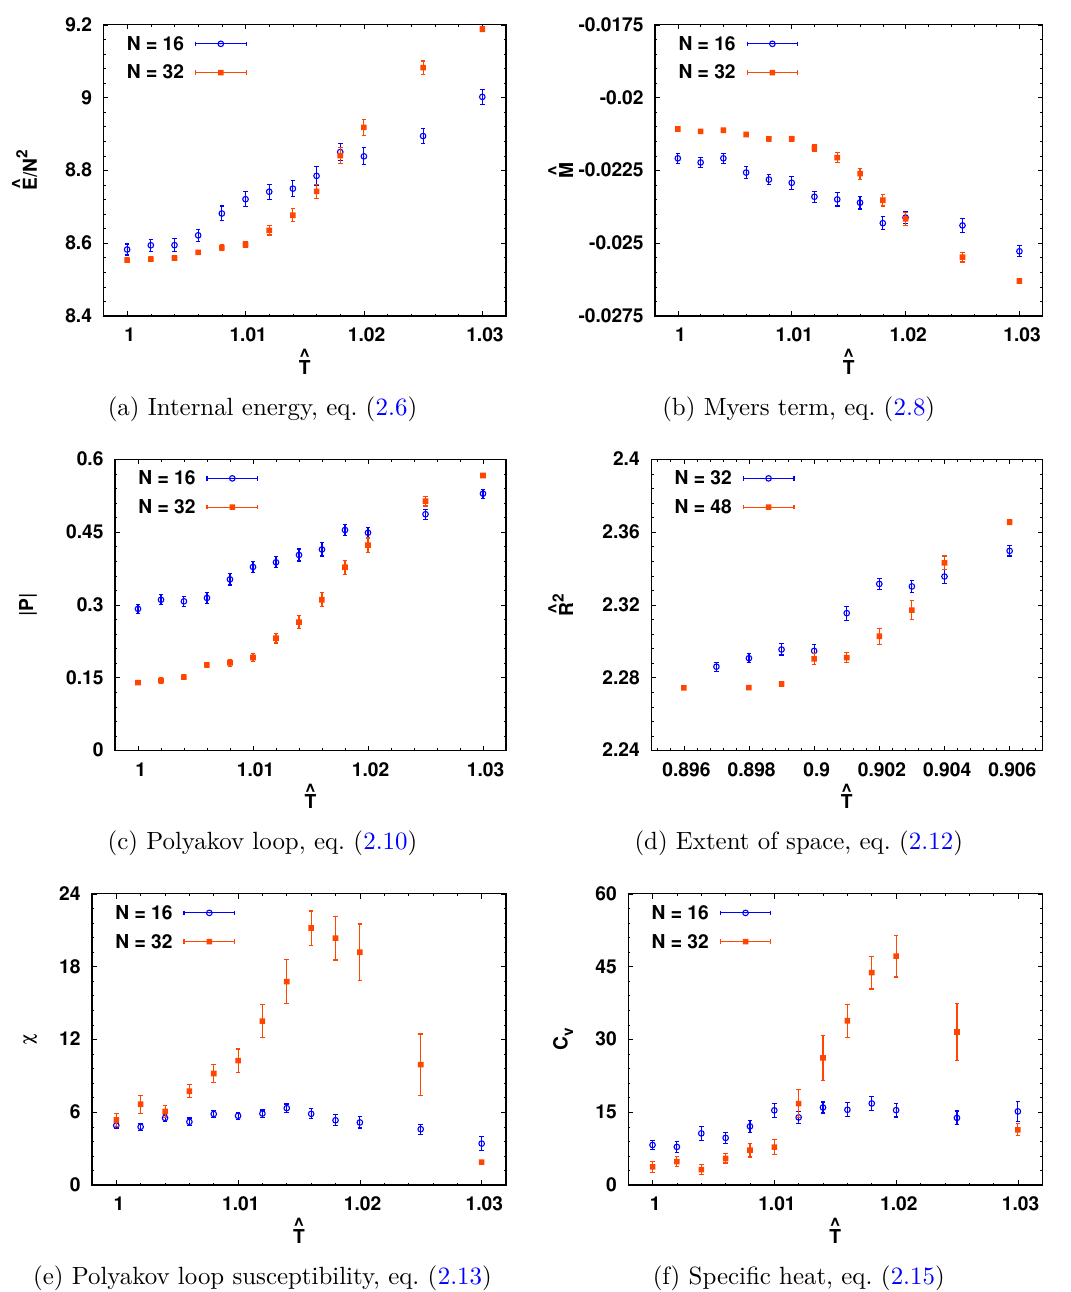
Figure 2. The six observables discussed in the text, for of temperatures 1 ≤ b T ≤ 1 . 03 around the transition. As in figure 1, increasing N from 16 to 32 produces clear growth in the Polyakov loop susceptibility and the specific heat peaks in the final